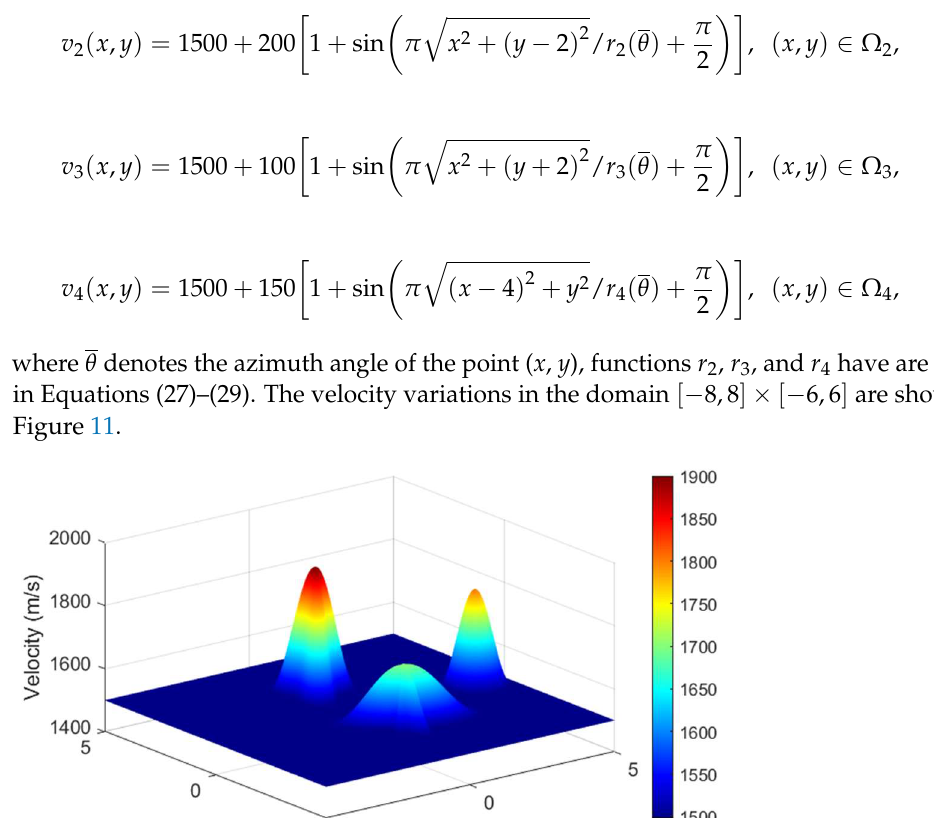
Figure 10. Geometry of the heterogeneous medium in Example 3.